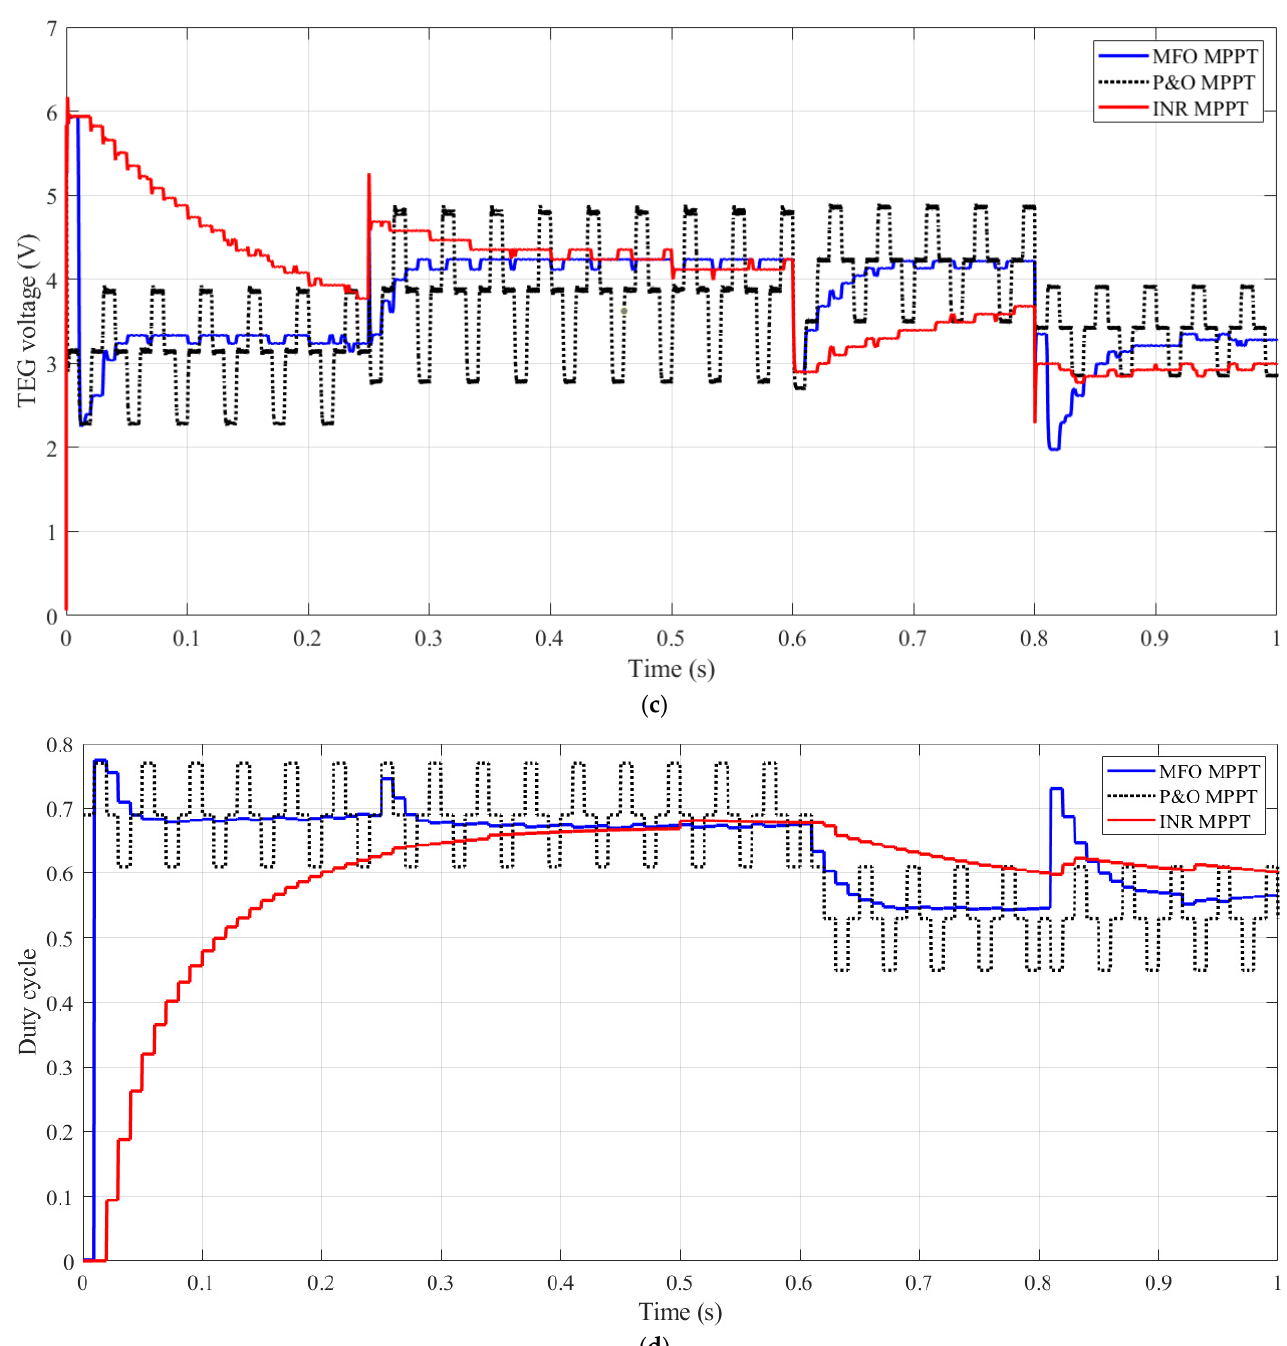
Figure 9. Detailed tracking performance using different MPPTs. ( a ) TEG power, ( b ) TEG current, ( c ) TEG voltage, and ( d ) duty cycle.